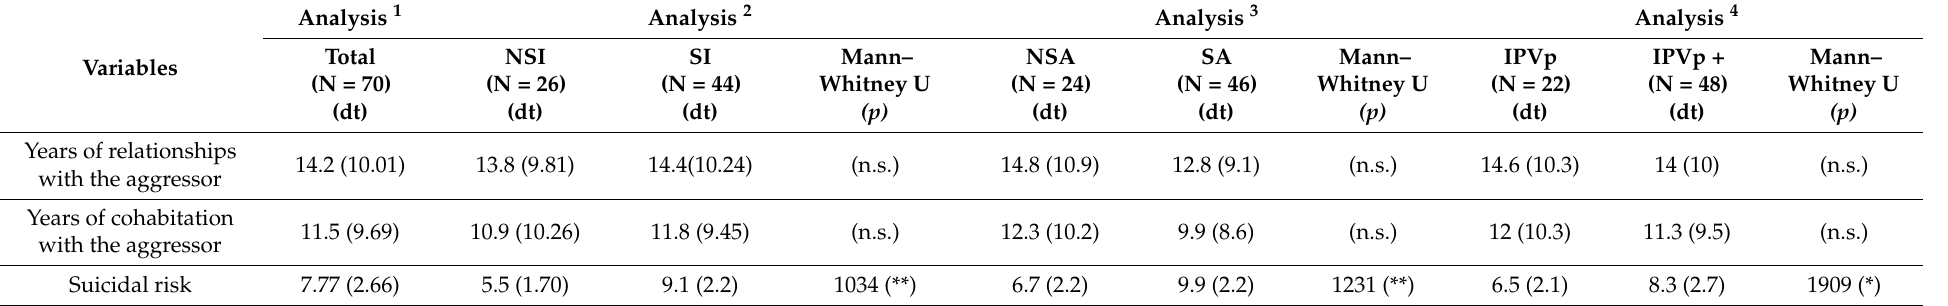
Table 4. Quantitative analysis of the experience of gender violence according to suicidal behaviour and type of